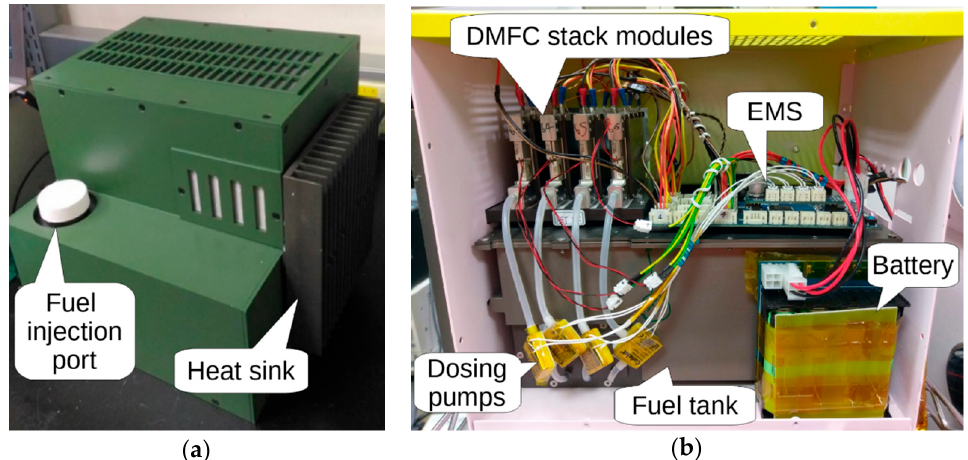
Figure 6. Portable DMFC power station. ( a ) Front view; ( b ) rear view internal configuration